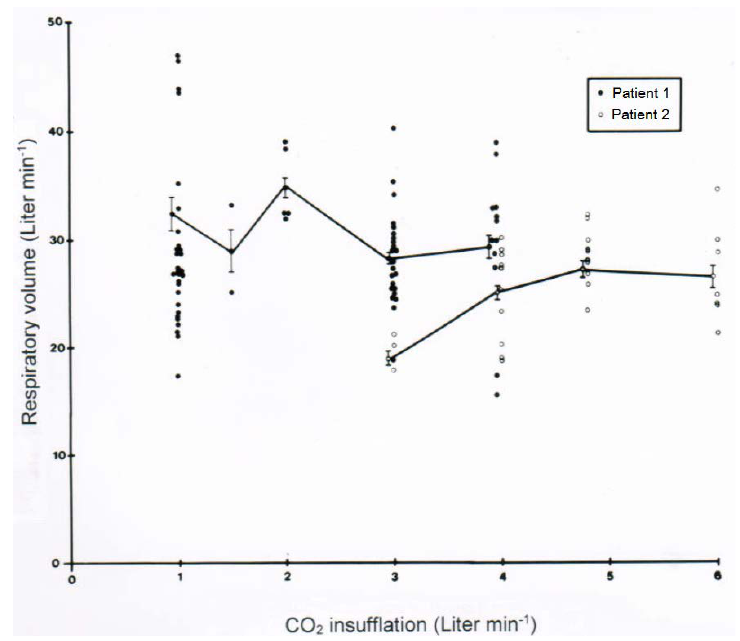
Figure 9. Effect of a variable CO 2 flow min −1 on the respiratory volume min −1 was assessed in 2 patients.